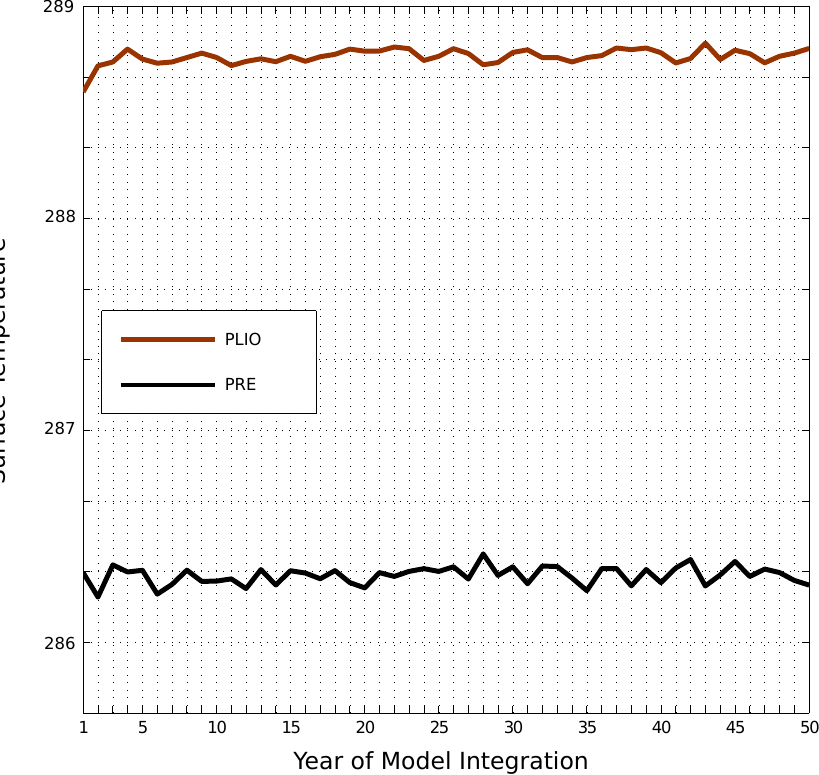
Fig. 1. Equilibration time for scenarios using the atmospheric component of the coupled GENESIS v3. GCM. Surface temperature (2-m) [ ◦ K] for pre-industrial (black) and Pliocene scenario (dark red) for Experiment 1 for year 1 to 50 of the integration. Results presented herein are averaged over the last 30 years of each integration.